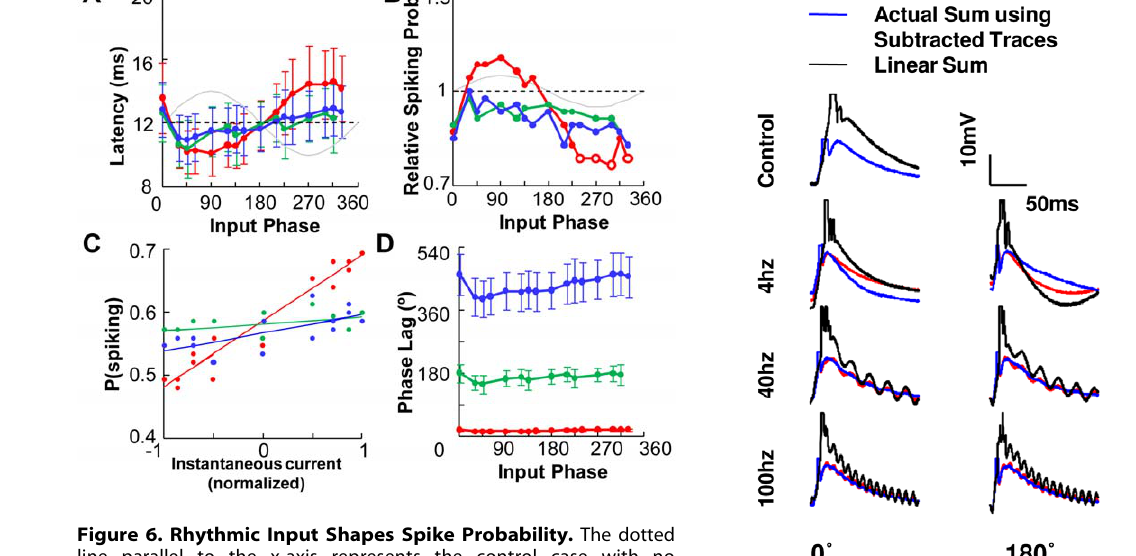
Figure 6. Rhythmic Input Shapes Spike Probability. The dotted line parallel to the x-axis represents the control case with no background current injection and the sinusoidal gray trace shows the somatic current injected at the input phases. Error bars represent SE. ( A ) Latency of evoked APs by summed inputs (N=12 cells) is also a function of the phase. It is not significantly affected by the summation. ( B ) Probability of spiking is tuned to input phase for summed inputs. The probability dipped significantly between 225–330 degrees only for theta frequency background. In the case of the gamma frequency backgrounds, the probability was below the control (without back- ground current injection) for all values of input phase. Data points that are significantly higher or lower (Binomial Test, p , 0.05) than control are represented as open symbols. ( C ) High positive correlation between the probability of spiking and the instantaneous current injected at input phase is seen with only theta frequency background. The lines indicate the best fit found using linear regression (R 2 of 0.93, 0.18 and 0.46 for theta, slow and fast gamma frequencies respectively). Data shown for only summed synaptic inputs. ( D ) Phase lag remains constant with changing input phase. This relationship remains unaffected on summation for all three background frequencies.